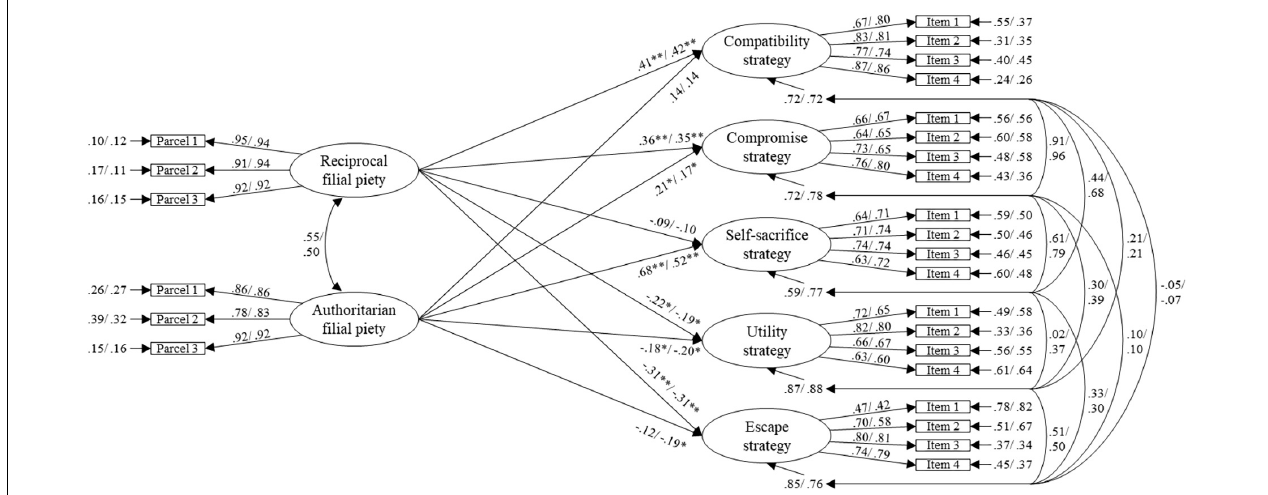
FIGURE 1 | Structural model of dual filial piety and parent–adolescent conflict resolution strategy in Study 1. The influence of the adolescent’s gender has been controlled in this model. All coefficients are standardized solutions; the first coefficient is the father–child model ( n = 231), the second is the mother–child model ( n = 238). * p < 0.05, ** p <